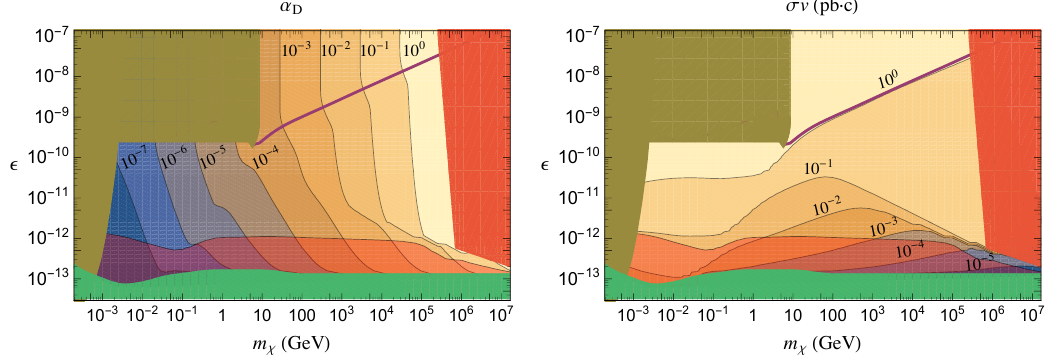
Figure 5. Left: values of (cid:11) D that produce the correct relic abundance. Right: the corresponding annihilation cross-section (in pb (cid:1) c). On each plot the equilibration (cid:13)oor is shown by the purple line. At high masses, the annihilation becomes non-perturbative. At low masses, various constraints from the CMB, self-interactions, and direct constraints on B (cid:0) L vectors forbid any valid dark matter solutions (olive) as will be discussed in section 4. At small (cid:15) the model encounters the absolute coupling (cid:13)oor (dark green), below which the dark matter abundance is never large enough to produce the observed relic density. Above this, in shaded red the sector does not satisfy our internal thermalization conditions (appendix